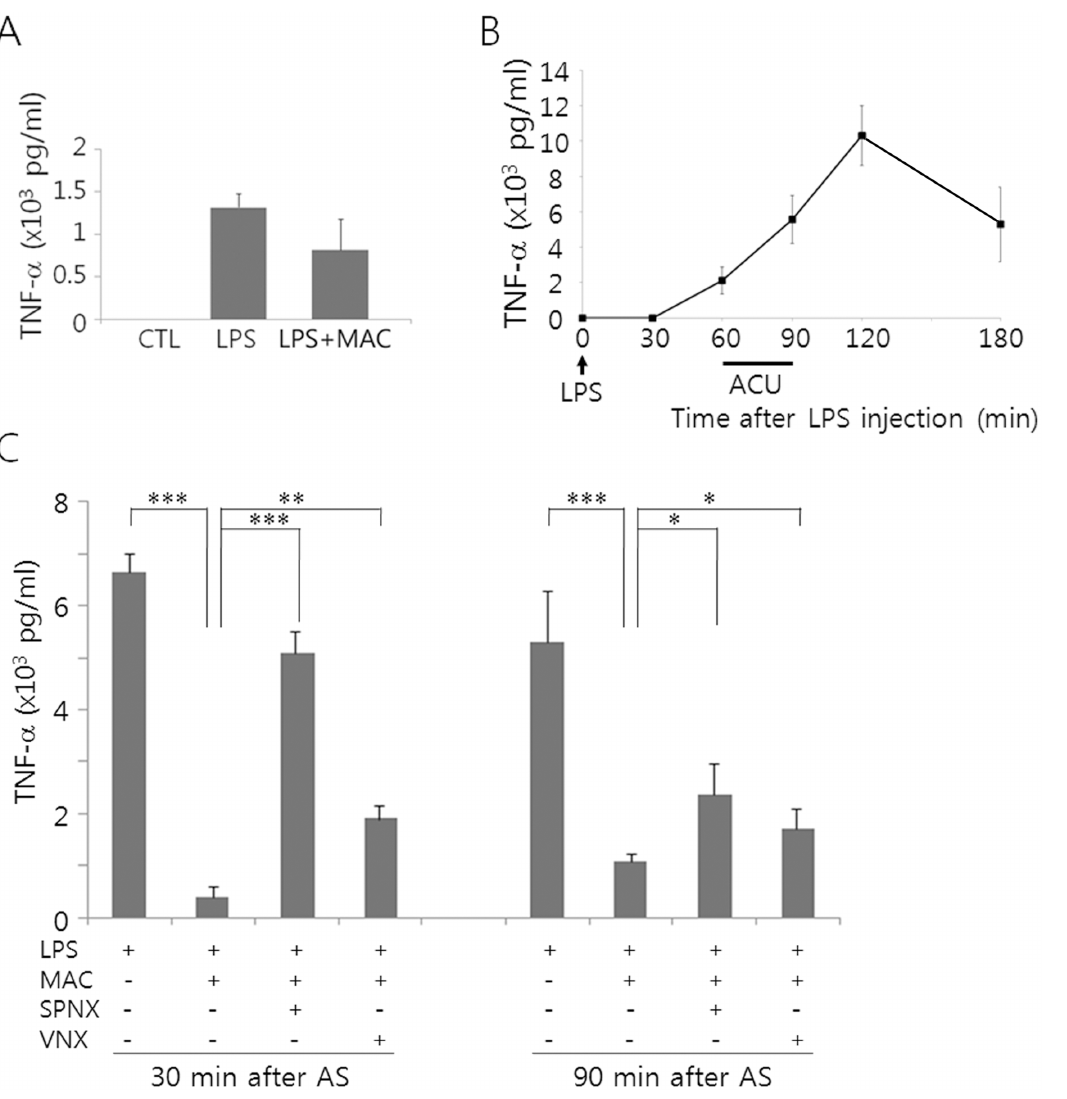
Fig 1. Profile of TNF- α production in the serum following AS in mice. (A) Comparison of TNF- α levels among the non-treated control (CTL), LPS (60 μ g/ kg), and the LPS plus MAC. MAC stimulation was given 60 min after LPS administration for 30 min, and TNF- α levels in the serum were compared 30 min after the acupuncture. (B) Time-dependent changes of TNF- α in the mice injected with LPS (15 mg/kg). (C) Comparison of TNF- α levels among animal groups with different treatments as indicated in the Figure. Data are means ± SEM [number of animals in each group = 3 in (A) and 4 in (B and C)]. * p < 0.01, ** p < 0.01, *** p < 0.001 (one-way